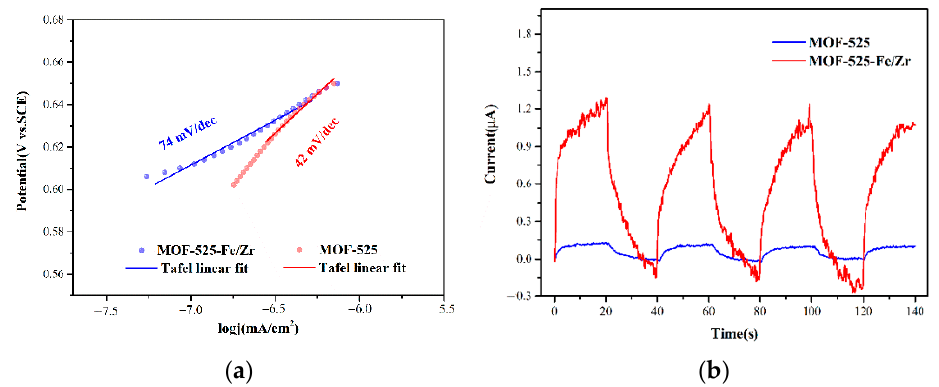
Figure 4. ( a ) Tafel slope and ( b ) transient photocurrent response of MOF-525 and